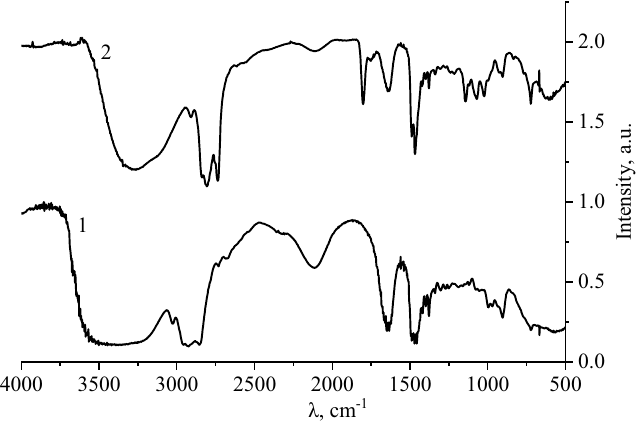
Figure 7. IR spectrum of selenium nanoparticles stabilized by DDAC: 1—DDAC; 2—Se NPs stabilized with DDAC.